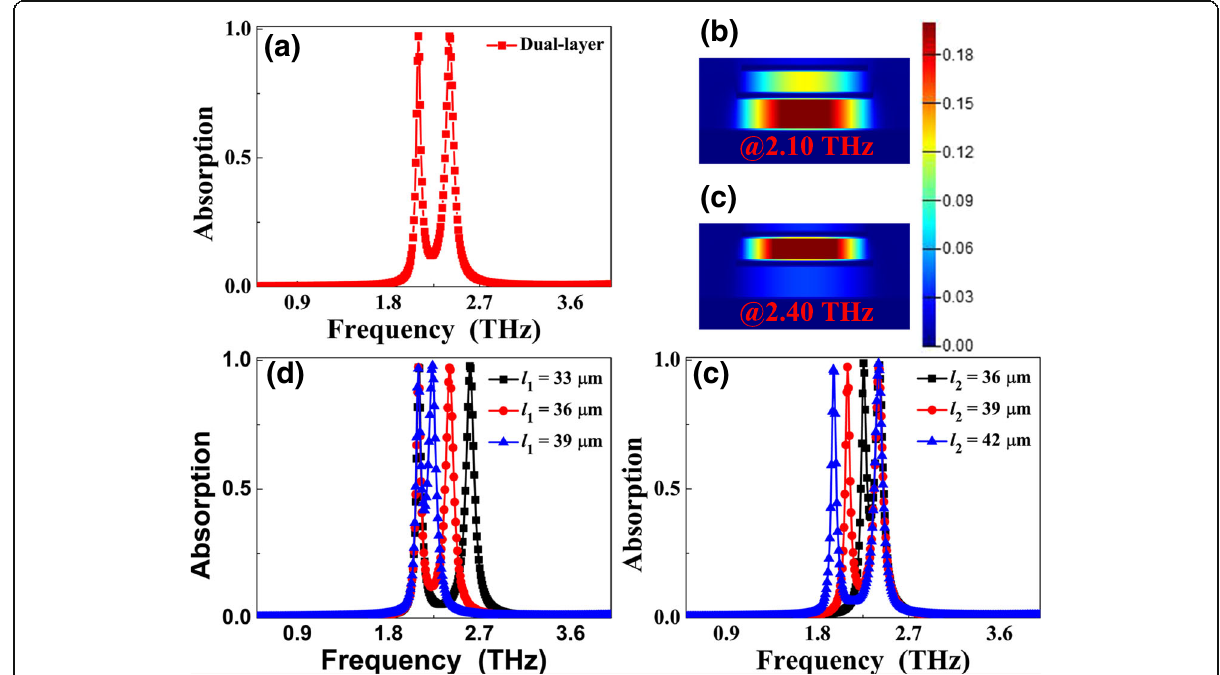
Fig. 3 Absorption curve of dual-band MPA under plane wave irradiation is presented in a ; b and c provide the | H y| field distributions of the first and the second modes of dual-band MPA, respectively. Absorption curves of dual-band MPA under different lengths of l 1 and l 2 are demonstrated in d and e ,